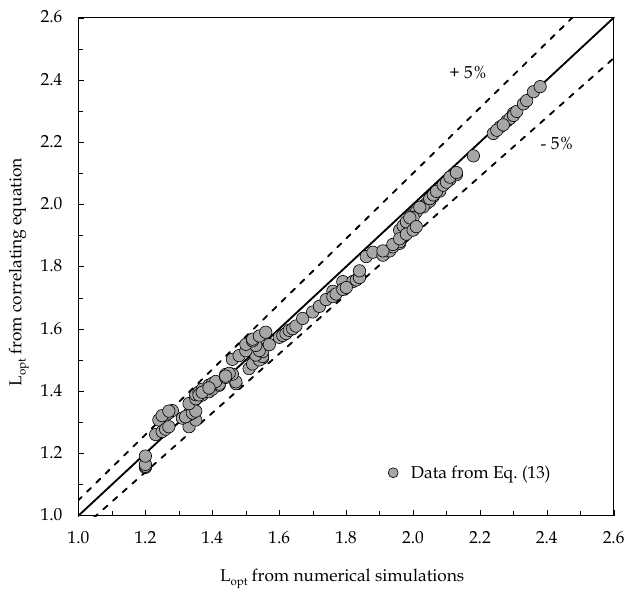
Figure 15. Comparison between Equation (13) and the numerical data obtained for L opt